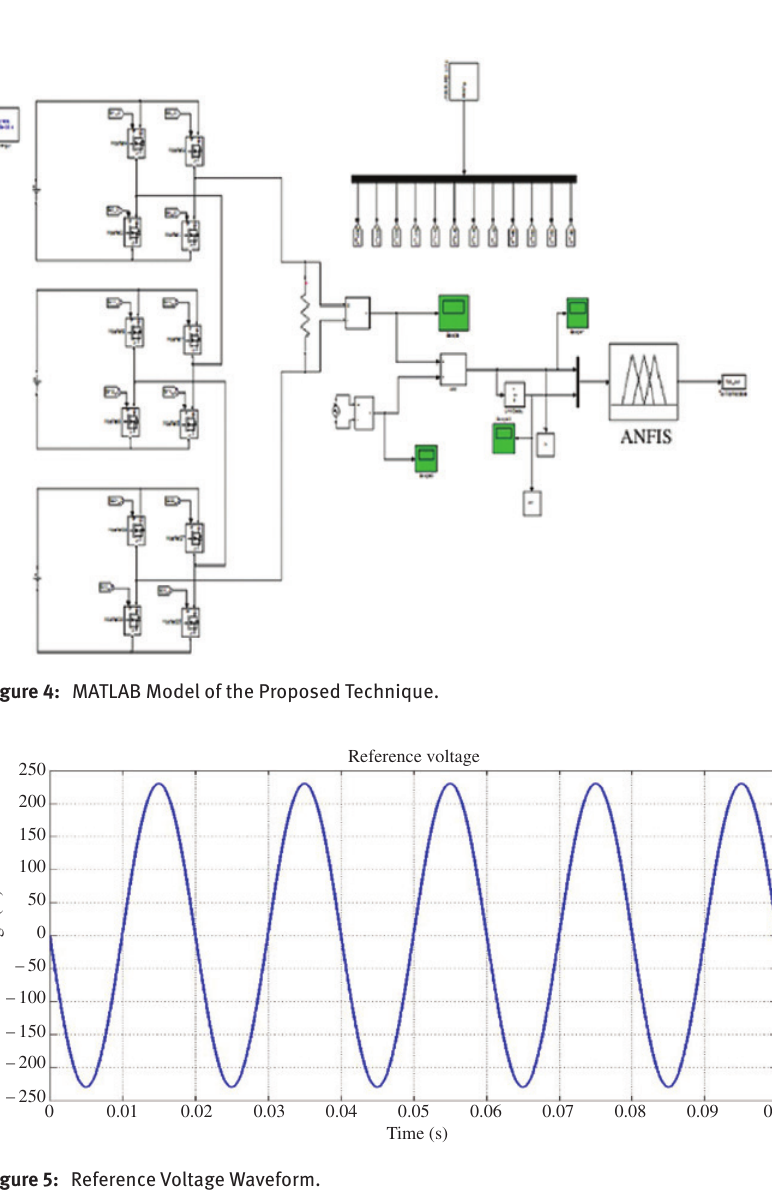
Figure 5: Reference Voltage Waveform.